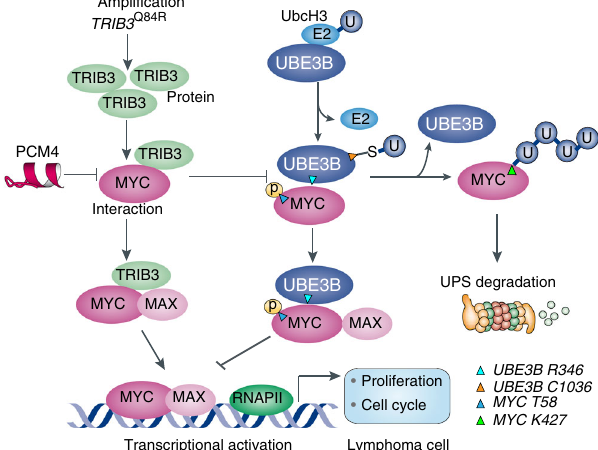
Fig. 9 Schematic diagram illustrates the TRIB3-UBE3B-MYC axis driving lymphoma development and progression. TRIB3 expression is enhanced in human lymphoma cells due to either the increased copy number in response to various stresses and nonsynonymous (Q84R) mutation of TRIB3 . Whereas, UBE3B, an E3 ubiquitin ligase, and UBCH3, an E2 ubiquitin-conjugated enzyme, have been identi fi ed to target MYC for proteasomal degradation. The enhanced TRIB3 interacts with MYC to decrease the UBE3B-mediated ubiquitination of MYC K427 and increase MYC stability; this interaction also supports the formation of MYC and MAX heterodimer. These actions enhance MYC transcriptional activity, causing high proliferation and self-renewal of lymphoma cells. Interfering with the TRIB3/MYC interaction enhances MYC degradation and suppresses the development and progression of high TRIB3/MYC- associated